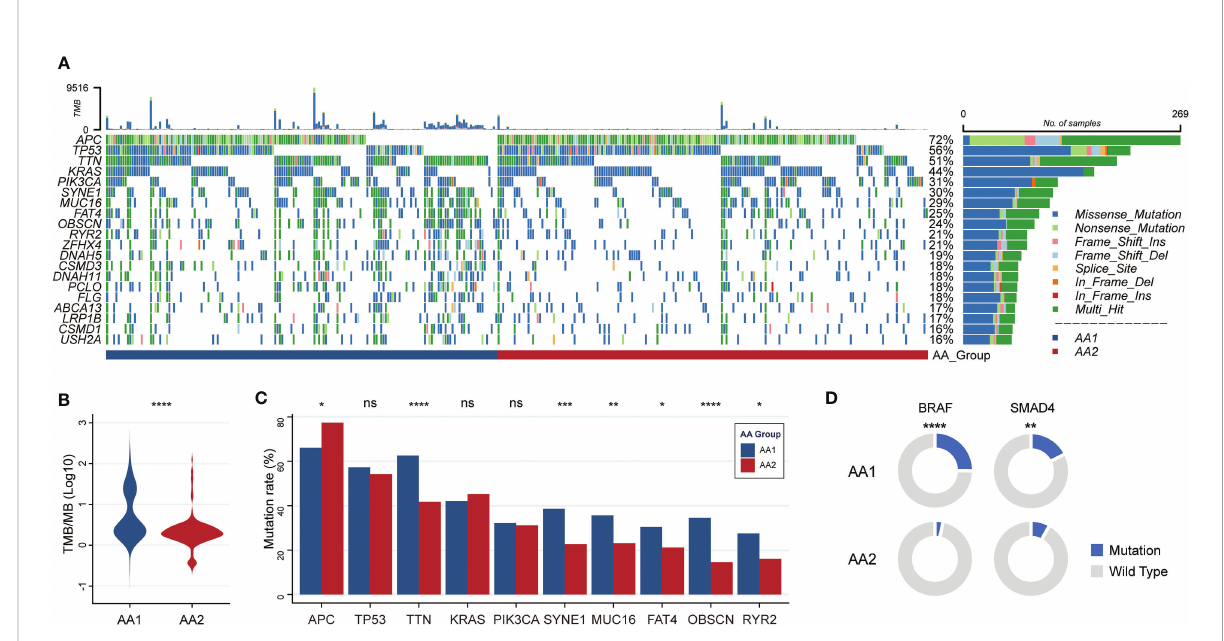
FIGURE 2 Correlation of the AA subtypes with tumor mutations. (A) OncoPrint of the mutation landscape of top 10 genes in AA1 and AA2 subtypes. (B) Tumor mutation burden between two subtypes. (Mann-Whitney Wilcoxon test) (C) The mutation rates of the most frequent mutant genes in two subtypes. (Chi-square test) (D) The mutation rates of key driver genes BRAF and SMAD4 in two subtypes. (Chi-square test). * P <0.05, ** P < 0.01, *** P < 0.001, **** P < 0.0001, n.s. , not signi fi